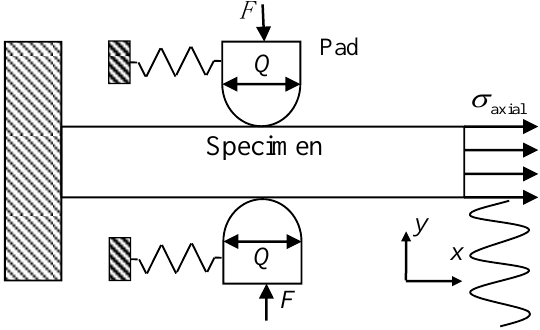
Figure 4. Schematic view of a fretting fatigue experiment.